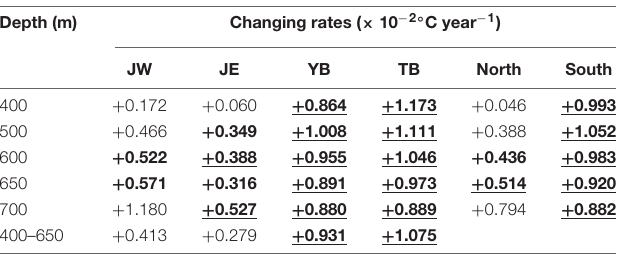
TABLE 1 | Changing PT rates in JW, JE, YB, and TB based on the Argo data. Bold and bold-underlined figures indicate statistically significant values at 95 and 99% confidence levels, respectively.